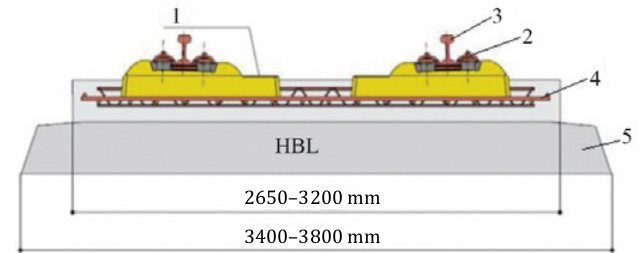
Figure 2. RHEDA 2000 slab track